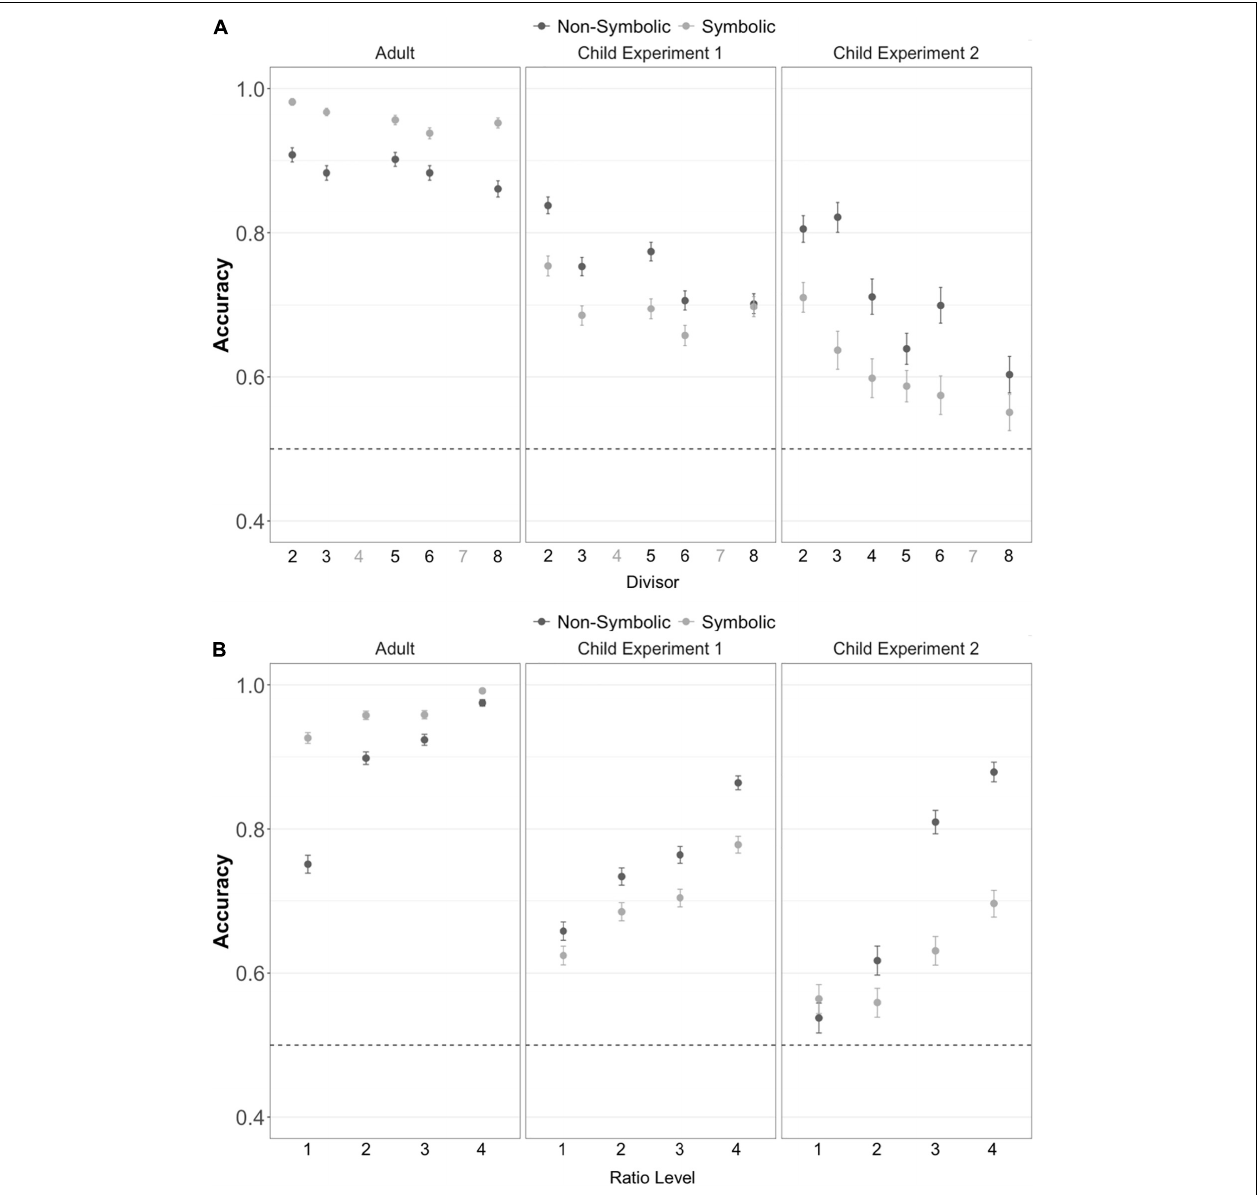
FIGURE 3 | Children and adults can successfully perform approximate division across (A) varied divisors and (B) ratios between the quotient and comparison quantity. Error bars represent the standard error of the mean. Divisors depicted in gray on the x-axis were not used in the experiment. Ratio level 1 ≈ 0.8, Ratio level 2 ≈ 0.6, Ratio level 3 ≈ 0.45, Ratio level 4 ≈ 0.35. The dotted line represents chance